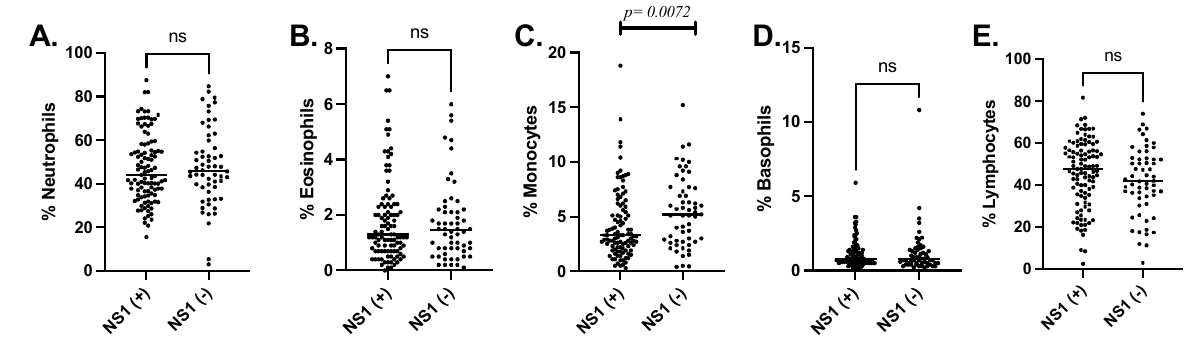
Figure 2. Leukocyte differential ( A ) Neutrophiles, ( B ) Eosinophils, ( C ) Monocytes, ( D ) Basophiles and ( E ) Lymphocytes reported in percentage of cells compared between patients with positive or negative DENV-NS1-Ag